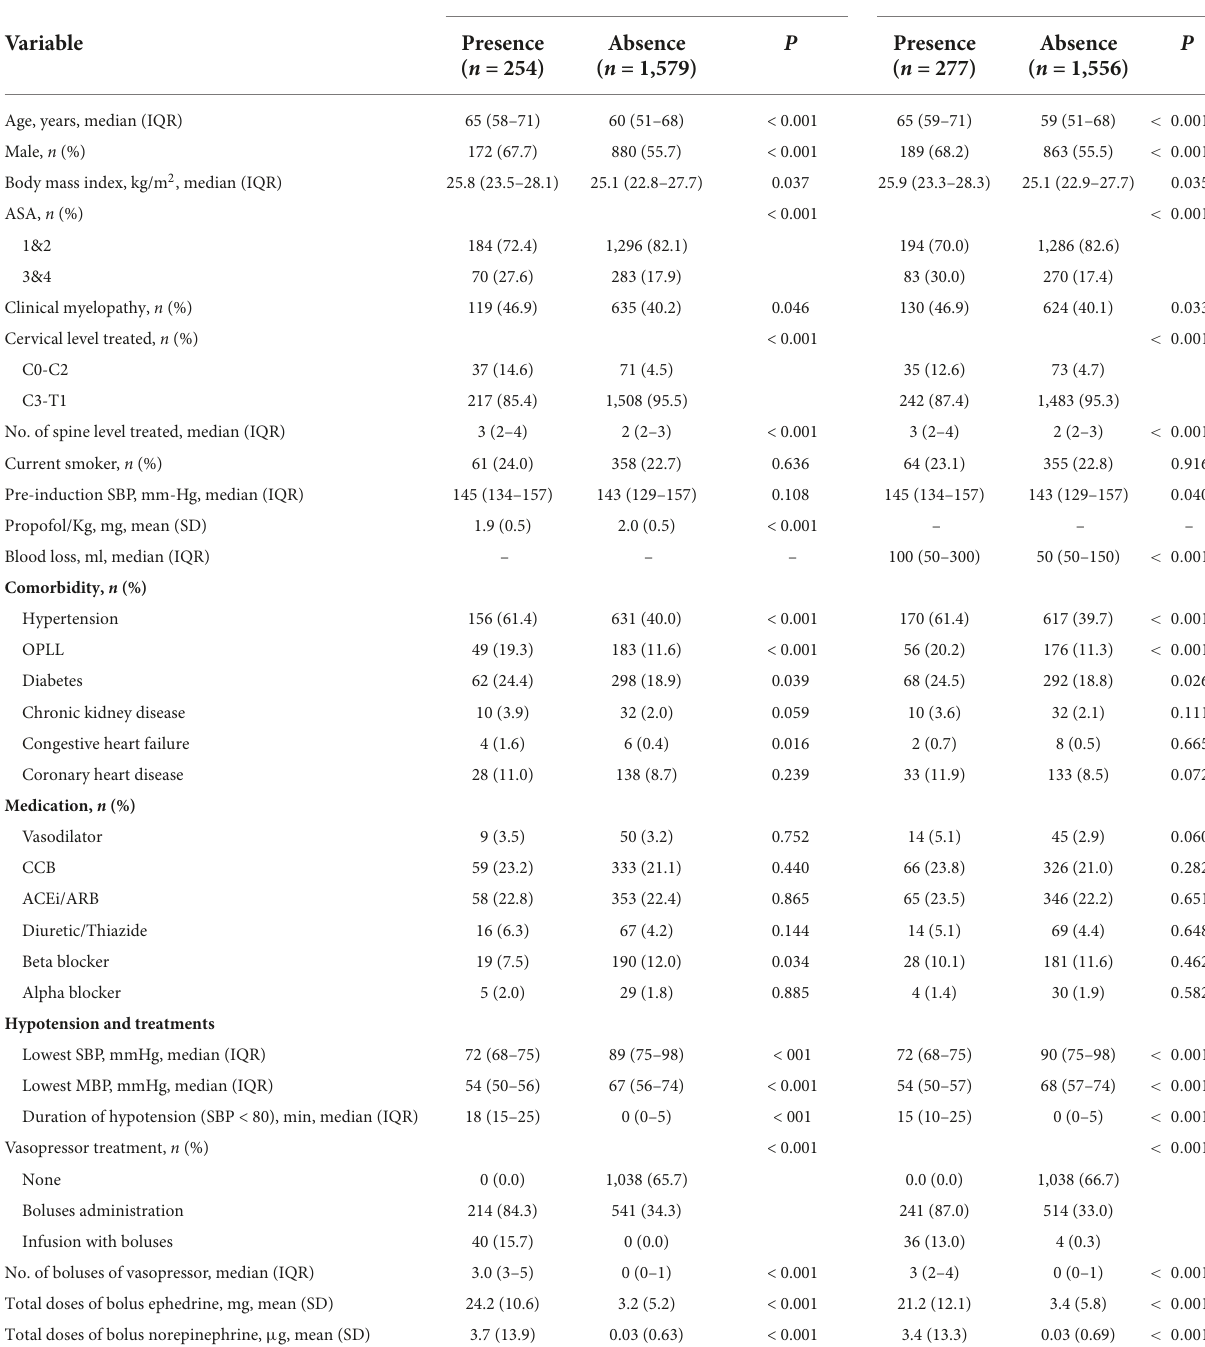
TABLE 2 Patient demographics in the post-induction and post-incision hypotension